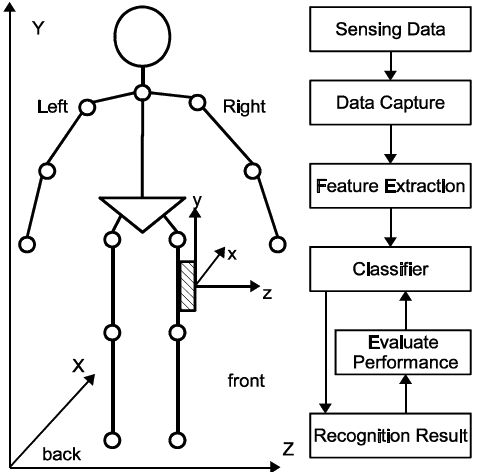
Figure 1. Overview of the proposed system architecture.